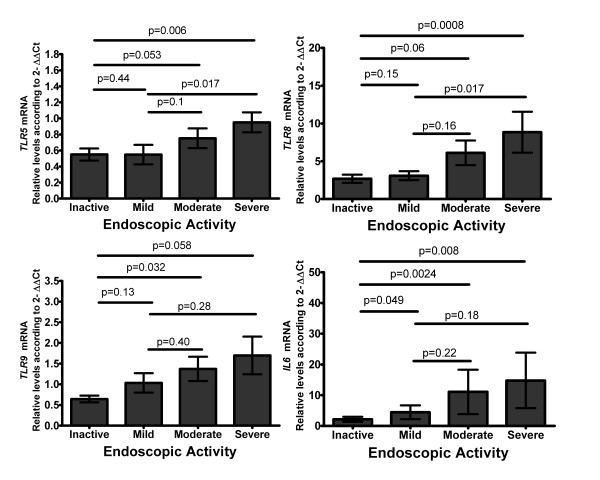
Toll-like receptors TLR5, TLR8, and TLR9 mRNA levels in Ulcerative Colitis correlate with Endoscopic Activity. RT-qPCR was performed to assess mRNA levels in colonic mucosa biopsies from UC patients according to Mayo subscore endoscopic activity, bars show means with standard error of the mean of TLRs and IL6 transcript levels with RPLP0 as housekeeping gene determined by 2-ΔΔCt, differences among groups were assessed by Mann-Whitney U test, and p values are presented in the figure.